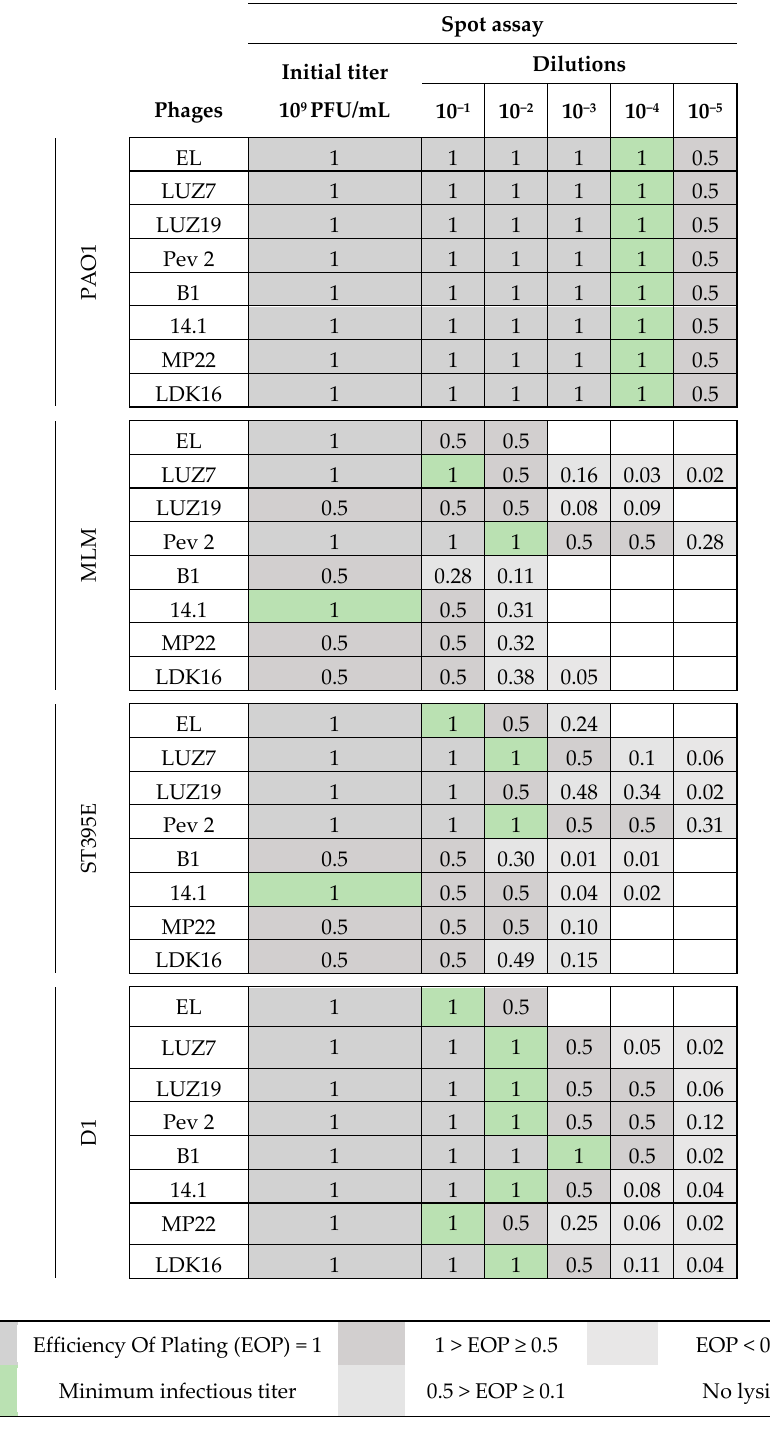
Table 5. Spot assay results. Phage deposits were performed onto the double layer through serial dilutions and EOP values calculated with the PAO1 strain as reference.